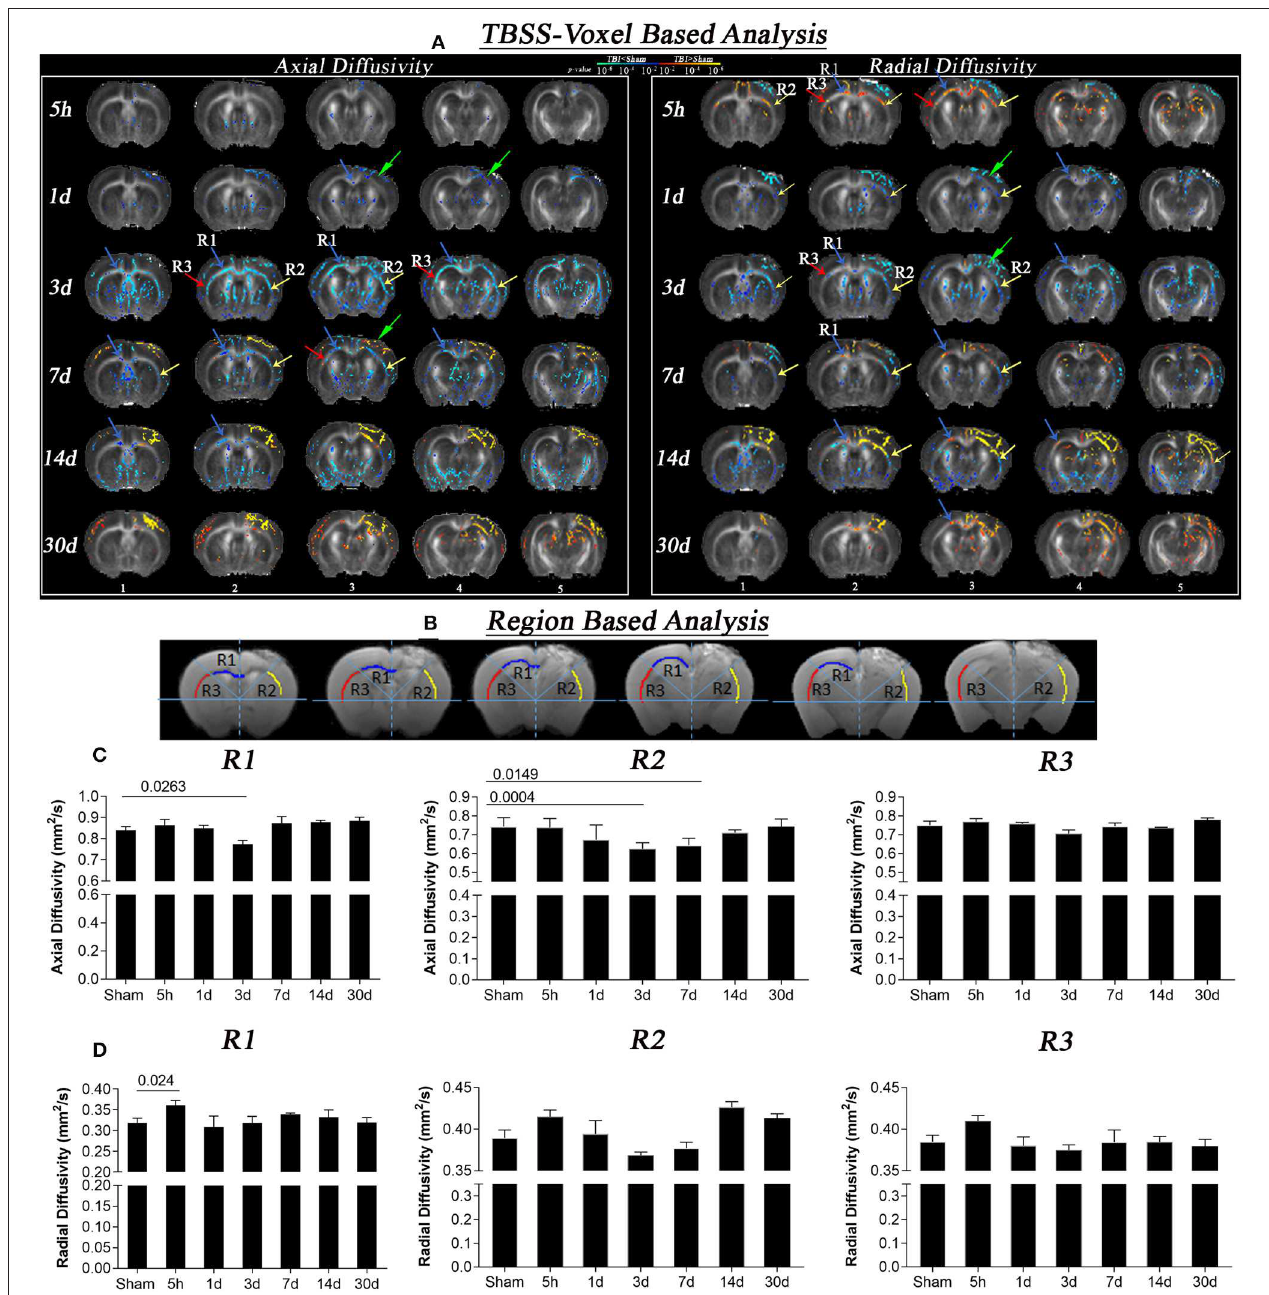
FIGURE 1 | Axial and radial diffusivity changes at different times after CCI (5h, 1 day, 3, 7, 14, and 30 days). (A) Whole brain TBSS voxel-based statistical difference maps for axial and radial diffusion, representing differences between TBI and sham groups at different time intervals post-injury Intergroup difference maps for axial (left) and radial diffusivity (right) between sham and TBI at different time points (red and blue color) overlaid on the mean FA template. Red color shows voxels with significantly higher DTI indices ( z = 1.96; p = 0.05), and blue color indicates voxels with significantly lower AxD and RD values ( z = 1.96; p = 0.05). Maximum changes in AxD were evident on day 3, where reduction was seen that persisted for 14 days. In RD maps, increase in diffusion at 5h followed by a decrease on day 3 further leads to increase after 7, 14, and 30 days post-injury was seen. Sections 1 to 5 refers to the interaural regions 3.5, 3, 2.5, 2, and 1.5mm as per AMBMC mouse brain atlas (51). (B) Representing regions of interest (region 1 (R1), region 2 (R2), and region 3 (R3) chosen on the basis of voxel based results. (C) Graphs representing changes in axial diffusivity in R1, R2, and R3. A significant decrease in AxD values was noted in day 3 TBI group as compare to sham group in R1 and R2 that persisted for day 7 post injury in R2. (D) Graphs representing changes in radial diffusivity in R1, R2, and R3. A significant increase in RD values was noted after 5h of injury as compared to sham group in R1. Non-significant reductions in RD in R2 were noted in R2 followed by non-significant increase at day 14 and 30 post injury. Values expressed as mean ± SEM and non-parametric student t -tests were performed; corrected p -value were reported.